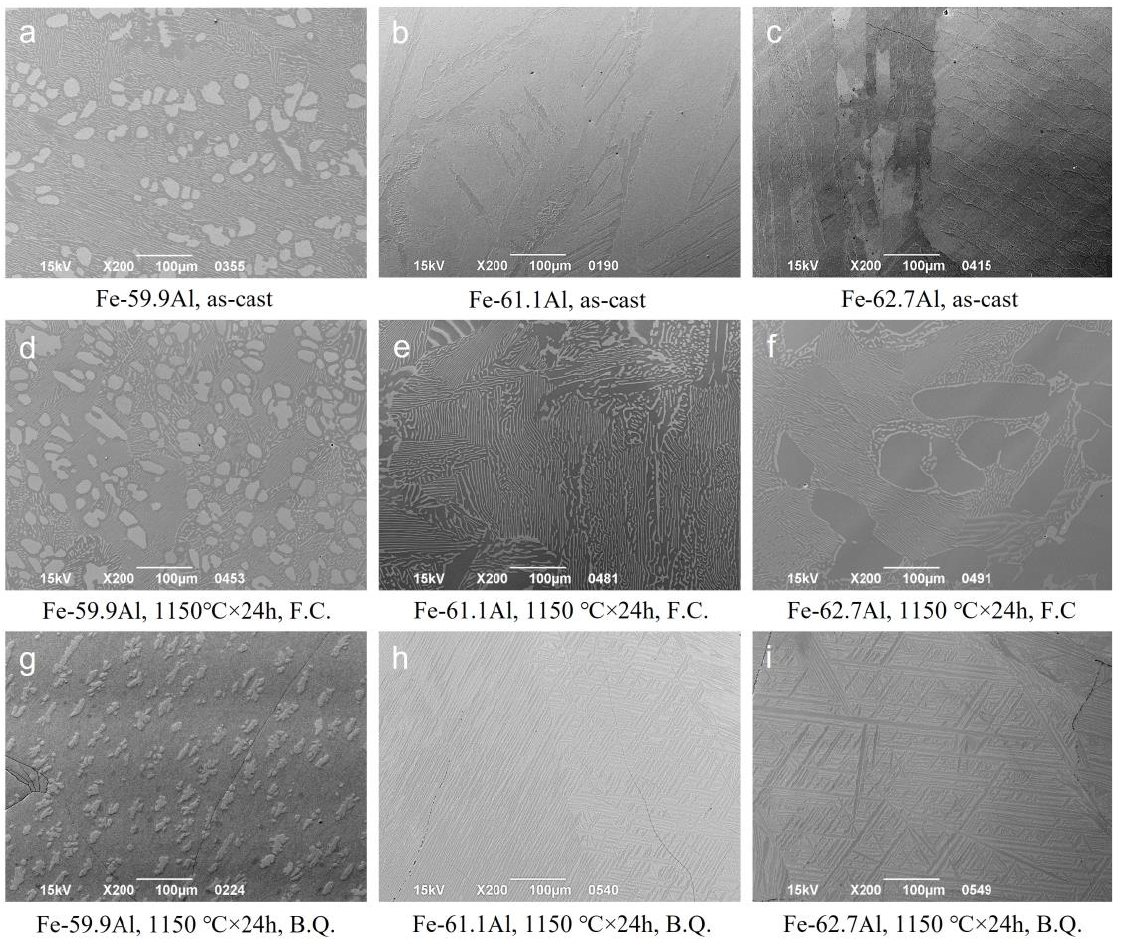
Figure 2. Selected SEM images of the investigated Fe-Al alloys (compositions in at.%).